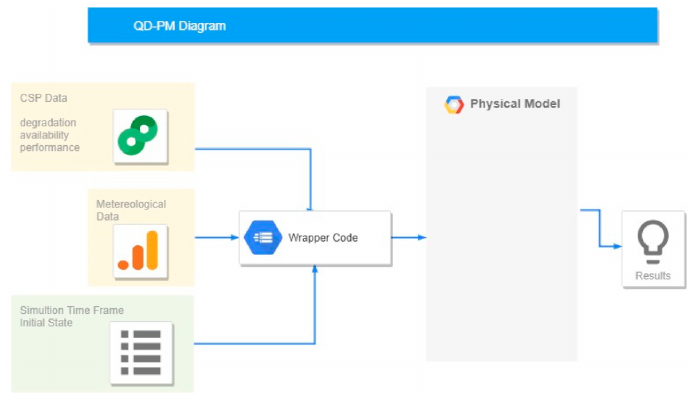
Figure 4. PM algorithm